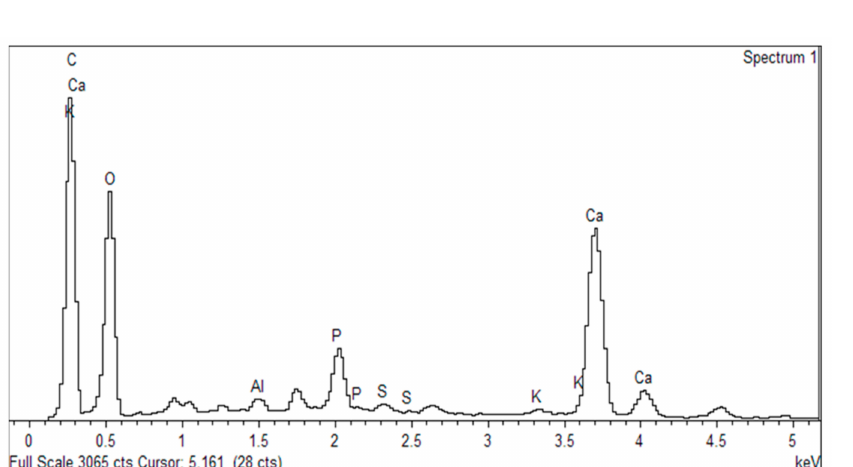
Figure 6. EDX analysis spectrum of C/SPS